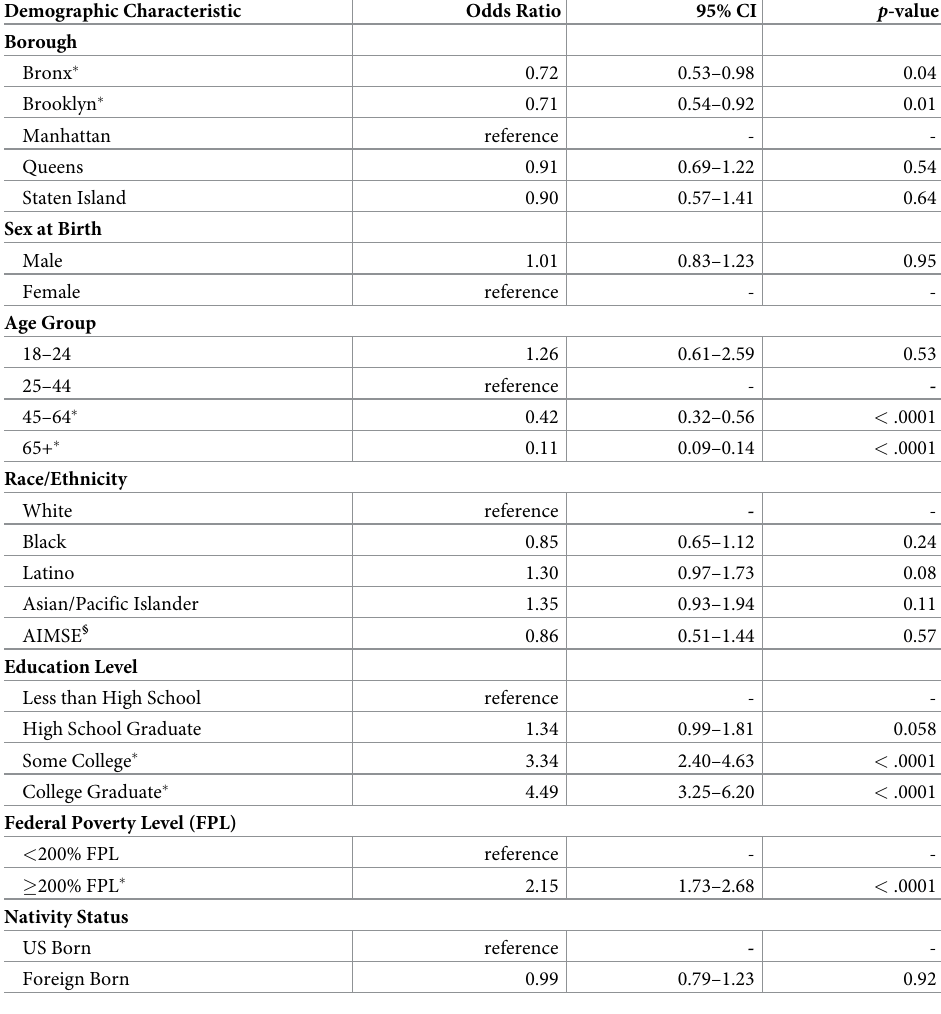
Table 2. Odds of providing an email contact at the time of Healthy NYC enrollment (n = 7,709) �� . Demographic Characteristic Odds